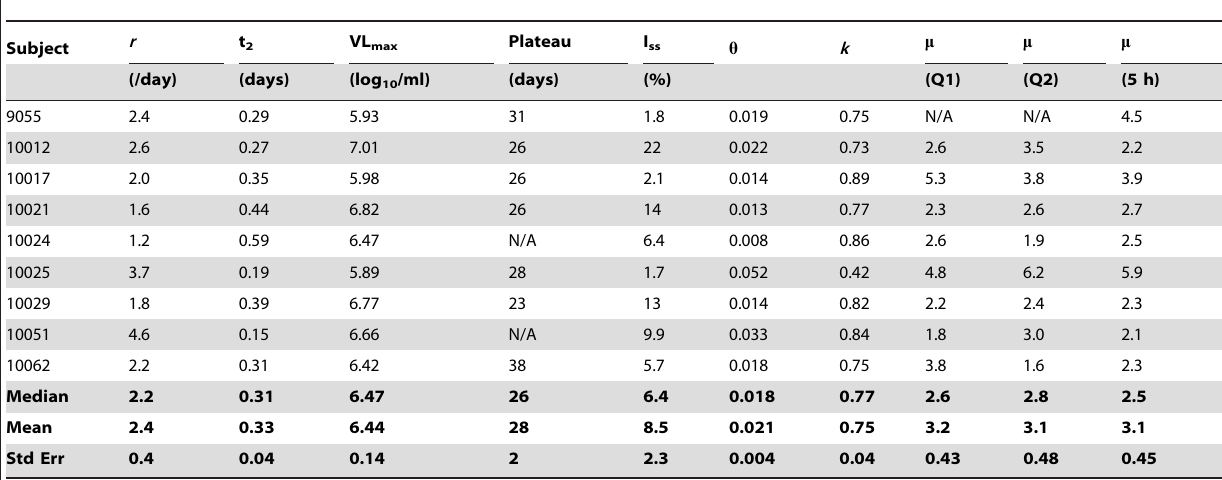
Table 1. Kinetic and simulation parameters for each subject